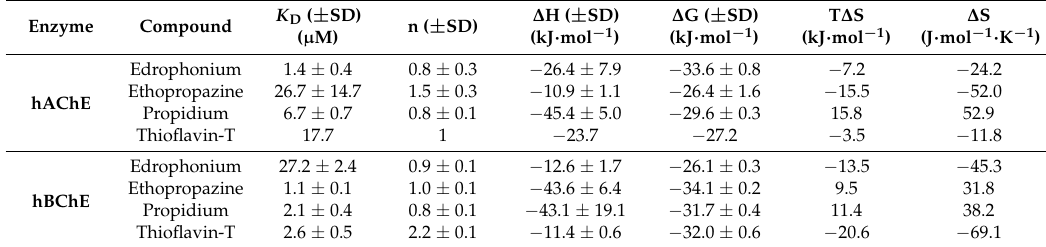
Table 2. ITC measurements for cholinesterase-ligand pairs. K D is the dissociation constant, n the binding stoichiometry, Δ H the binding heat, Δ G the Gibbs free energy of binding, and T ∆ S the entropy change, with Δ G = Δ H − T ∆ S. Where SDs are listed, the reported values are the mean ± SD of three independent experiments.